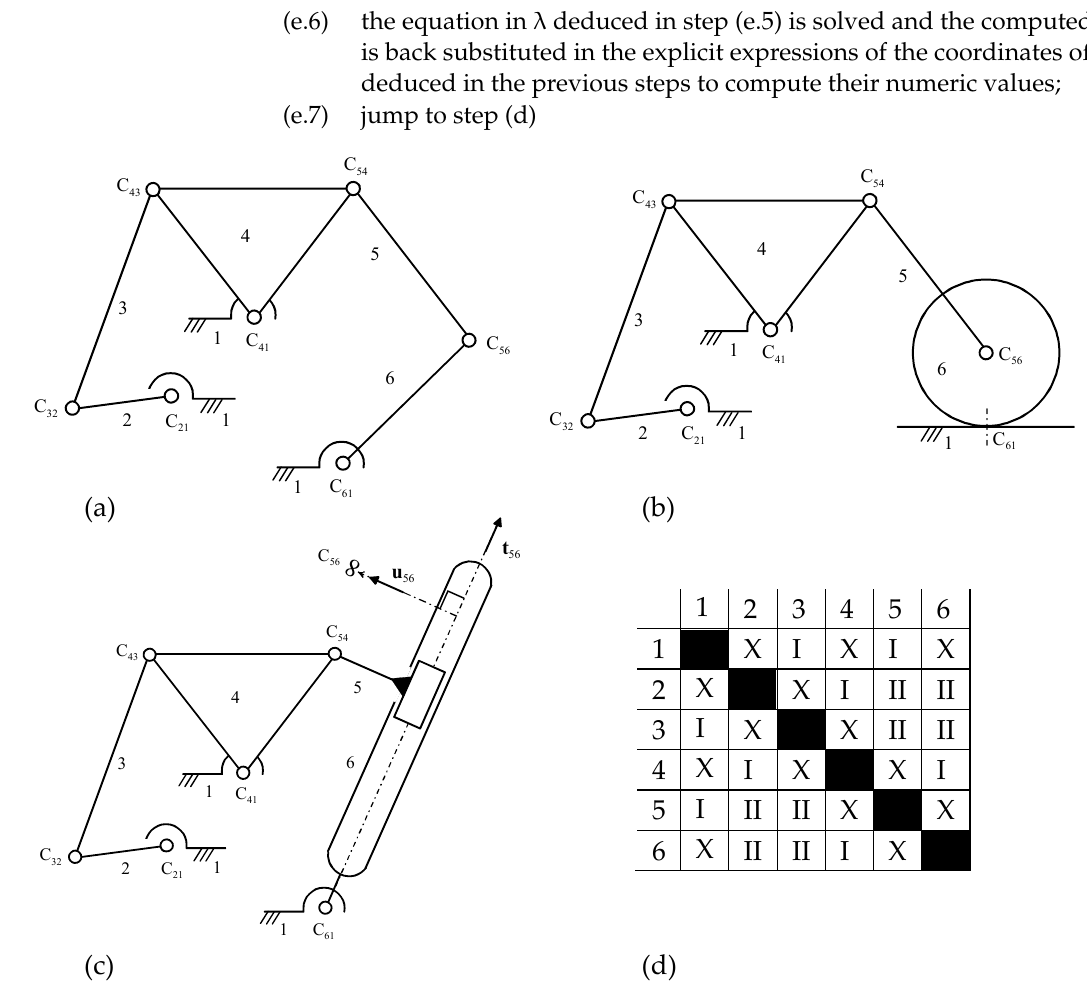
Figure 5. The three PMs ( a – c ) share the same table ( d ).